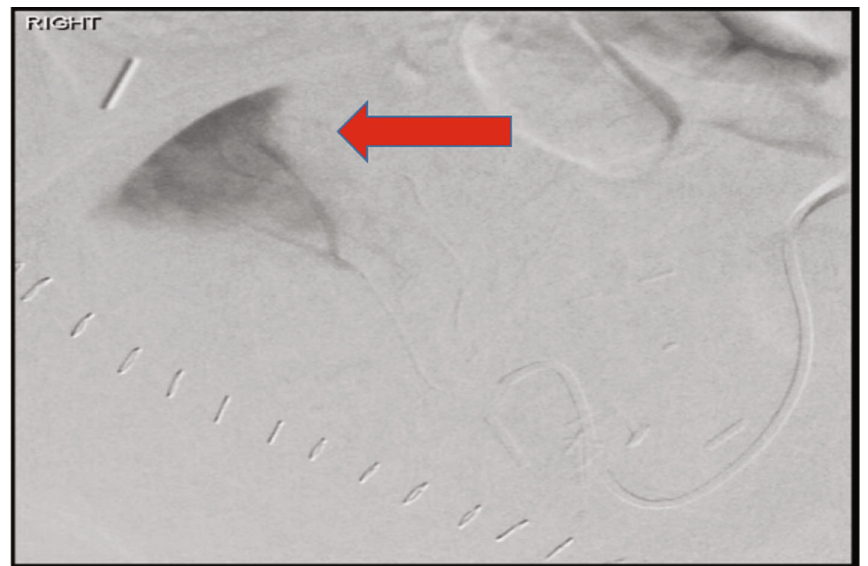
Figure 3: Interpolar region segmental renal artery (arrow): a small focus of early arterial fi lling was noted with associated early venous drainage demonstrating AVF.